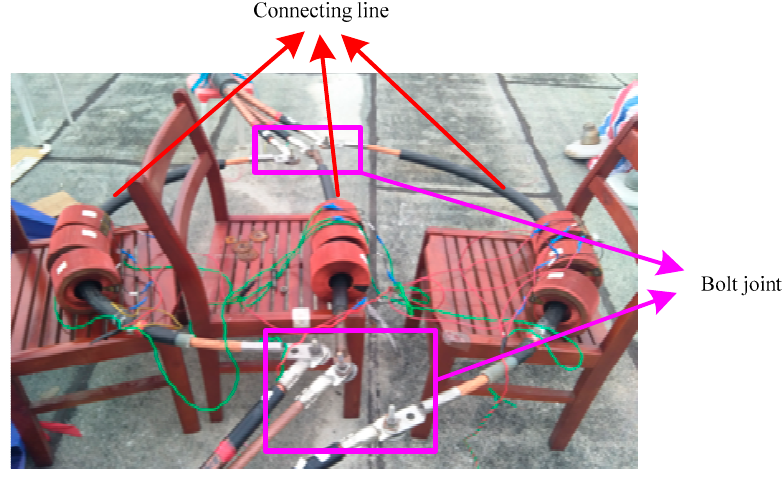
Figure 10. Photo of three-phase inducing transformers.